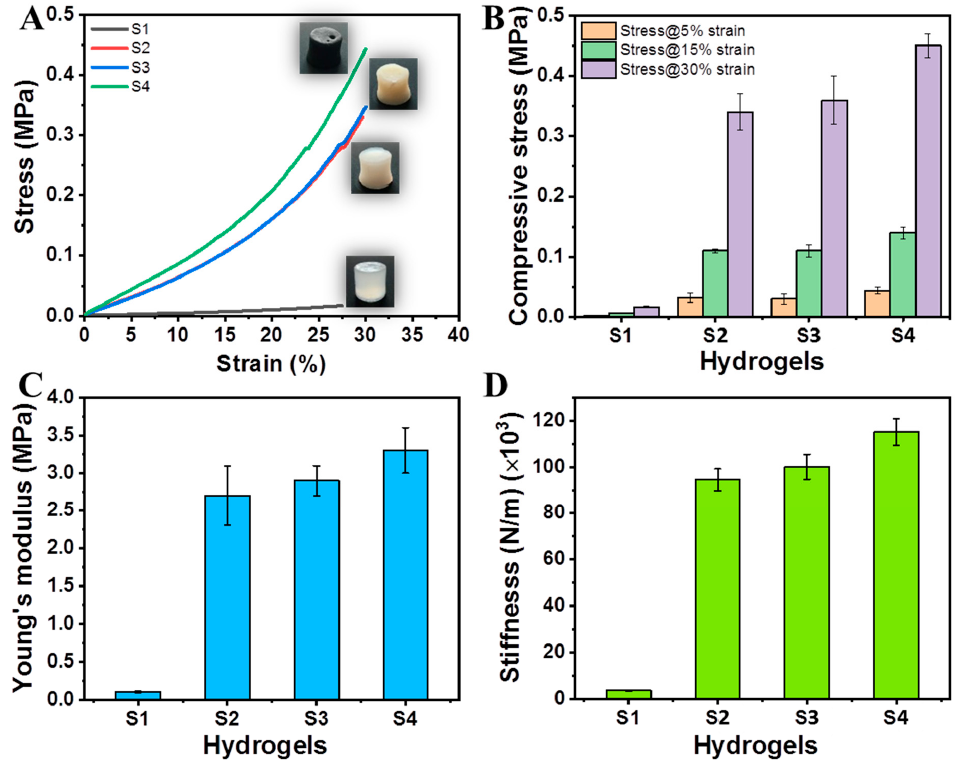
Figure 6. ( A ) Stress–strain curves; ( B ) compressive stress at three different strains (%); ( C ) Young’s modulus; and ( D ) stiffness values of hybrid hydrogels. Hydrogel S1 showed a compressive strength of 0.017 ± 0.002 MPa and Young’s mod- ulus of 0.11 MPa ± 0.01 without involving any of the crosslinking agents. However, by incorporating borax (B(OH) 4 − ) and ionic (Ca 2+ ) crosslinking together, hydrogel (S2) exhib- ited a remarkable improvement in compressive strength (0.34 MPa ± 0.03) and modulus (2.7 MPa ± 0.4). The effect of crosslinking the hybrid hydrogel S1 separately with borax and Ca 2+ on the mechanical attributes is shown in Figure S3.